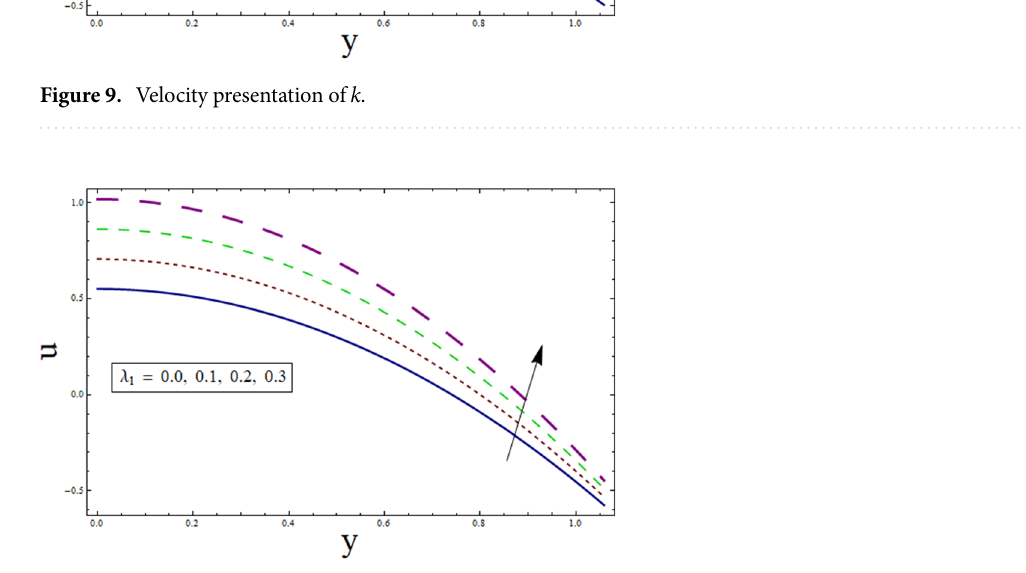
Figure 10. Velocity presentation of (cid:31) 1